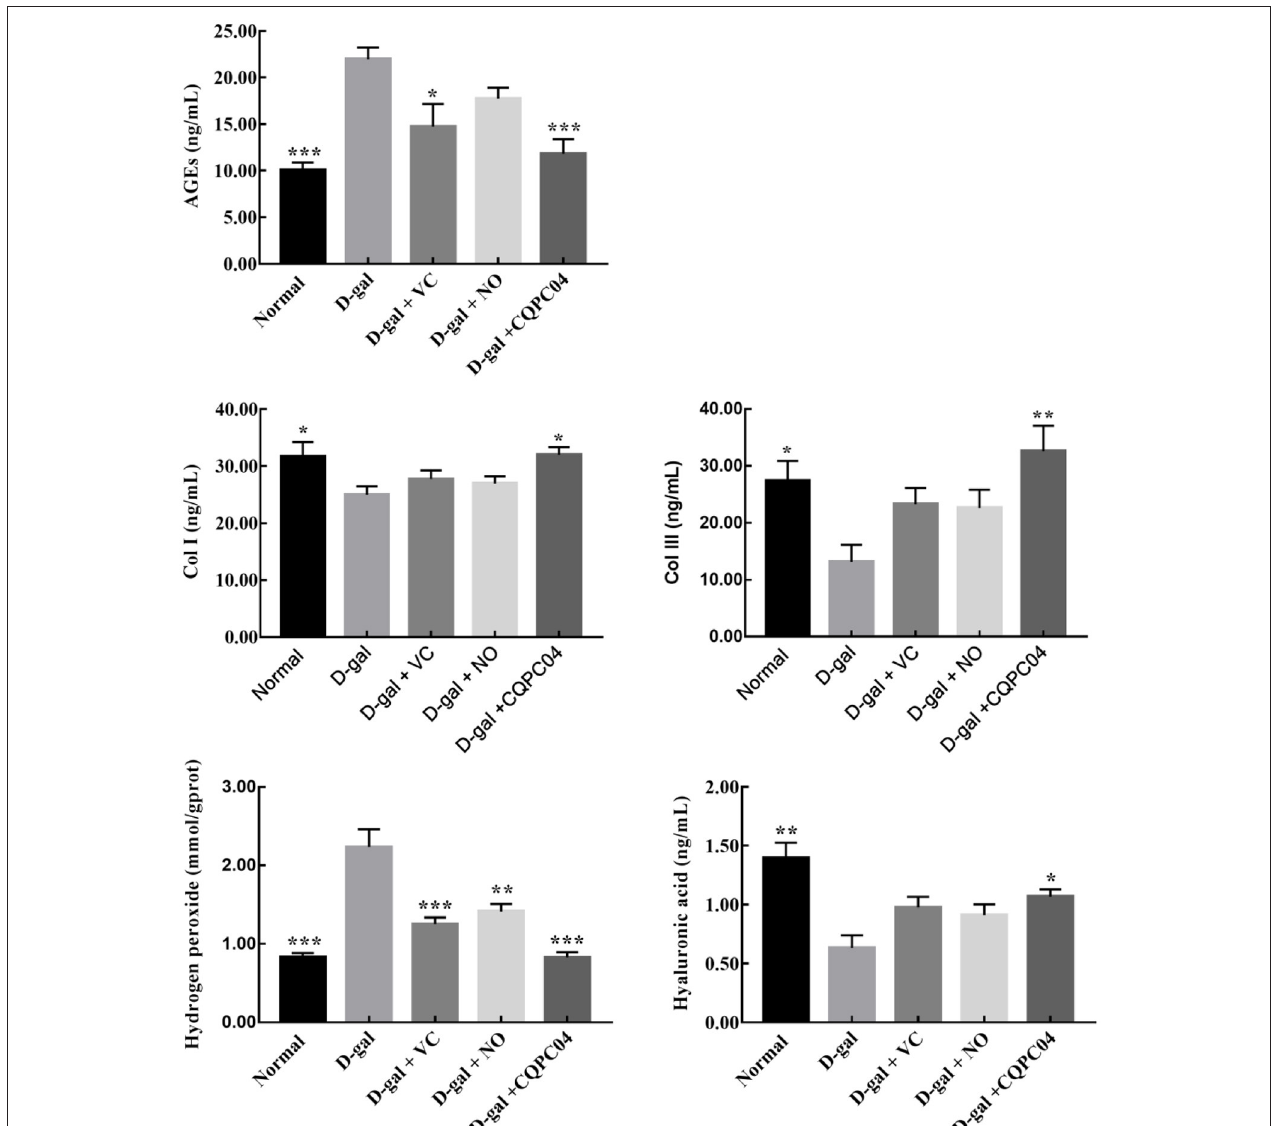
FIGURE 5 | Levels of Col I, Col III, AGEs, hyaluronic acid and hydrogen peroxide in skin tissue. D-gal: mice fed the standard chow diet plus drinking water with intraperitoneal injection of D-galactose (120 mg/kg of BW); D-gal + VC: vitamin C (100 mg/kg of BW) plus intraperitoneal injection of D-galactose (120 mg/kg of BW); D-gal + NO: non-fermented soy milk (0.1 mL/10g of BW) plus intraperitoneal injection of D-galactose (120 mg/kg of BW); D-gal + CQPC04: L. fermentum CQPC04-fermented soy milk (0.1 mL/10g of BW) plus intraperitoneal injection of D-galactose (120 mg/kg of BW). * p < 0.05, ** p < 0.01, and *** p < 0.001 compared to D-gal